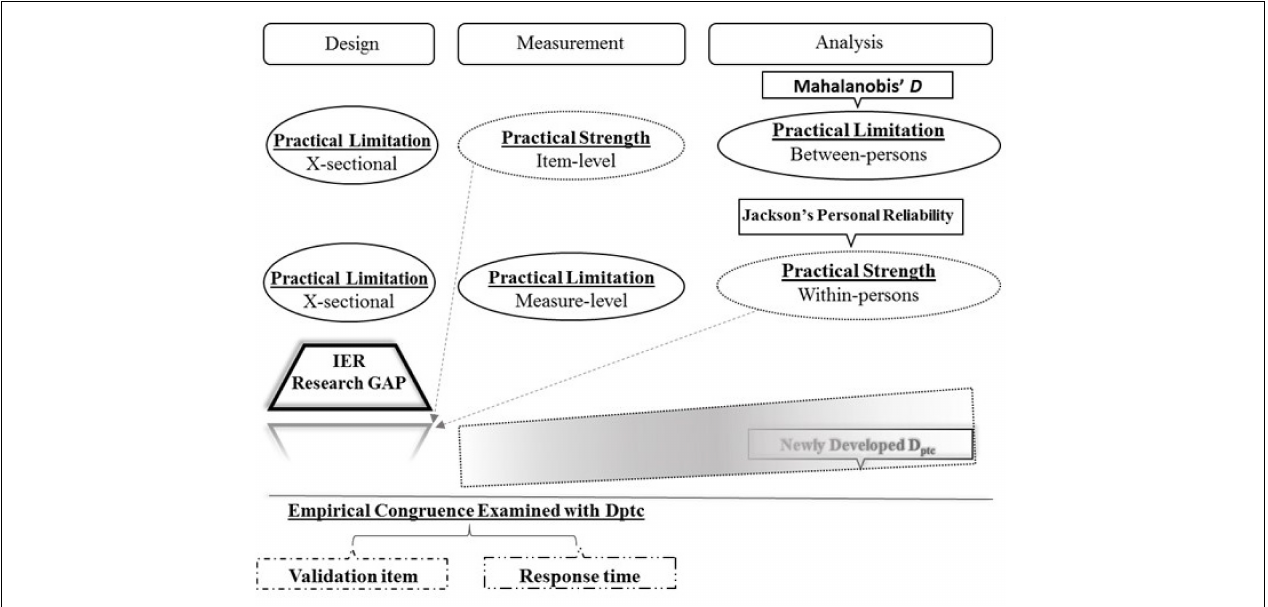
FIGURE 1 | Relational-framework illustrating IER research gap filled by new D ptc tool.